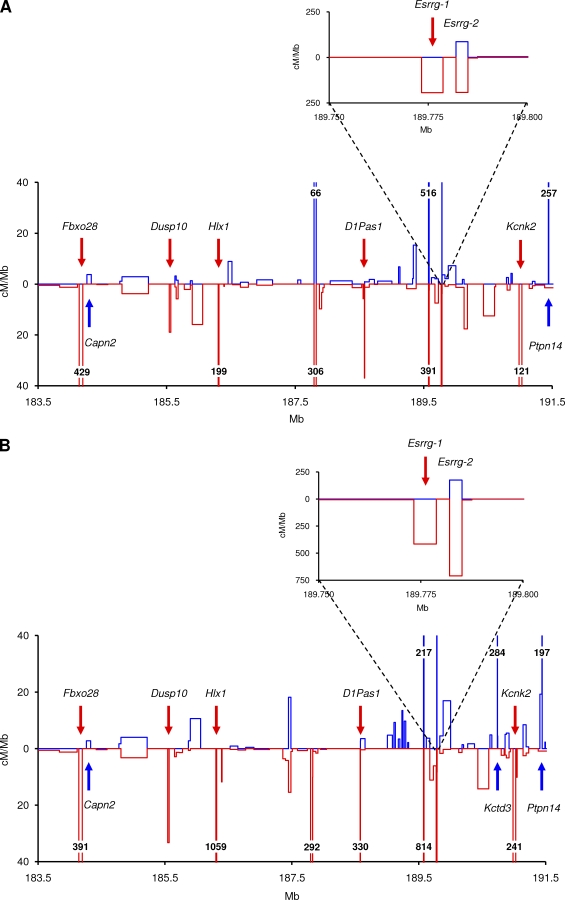
Recombination Map of the Chr 1 Region between 183.5 and 191.5 Mb(A) Comparison between the female maps of B6xB6.CAST-1T (blue line) and B6xCAST (red line).(B) Comparison between the male maps of the two crosses using the same colors. The maps of B6xCAST are taken from previous experiments [10].Recombination rates are expressed in centimorgans per megabase for the intervals between adjacent markers. Hotspots included in Table 1 are shown with their names and positions indicated by arrows. Red arrows mark hotspots where recombination was present only in the B6xCAST cross; blue arrows mark regions where recombination was present only in the B6xB6.CAST-1T cross. The numbers show actual centimorgans per megabase values for hotspots exceeding the limits of the figure. The insets expand the map in the 50-kb region between 189.750 and 189.800 Mb; the red arrow marks the Esrrg-1 hotspot that is active only in the B6xCAST cross.